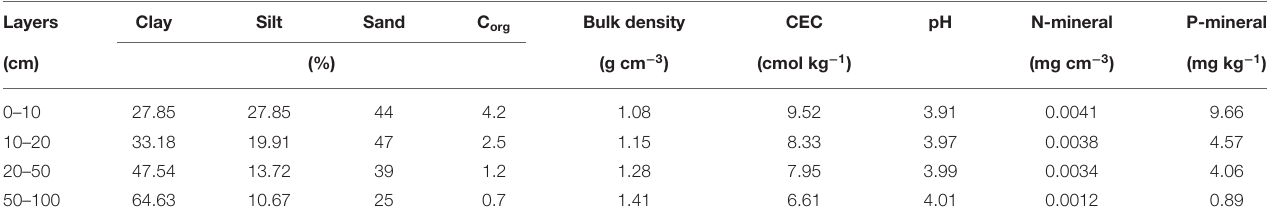
TABLE 1 | Soil characteristics of soil texture used for model parameterization.